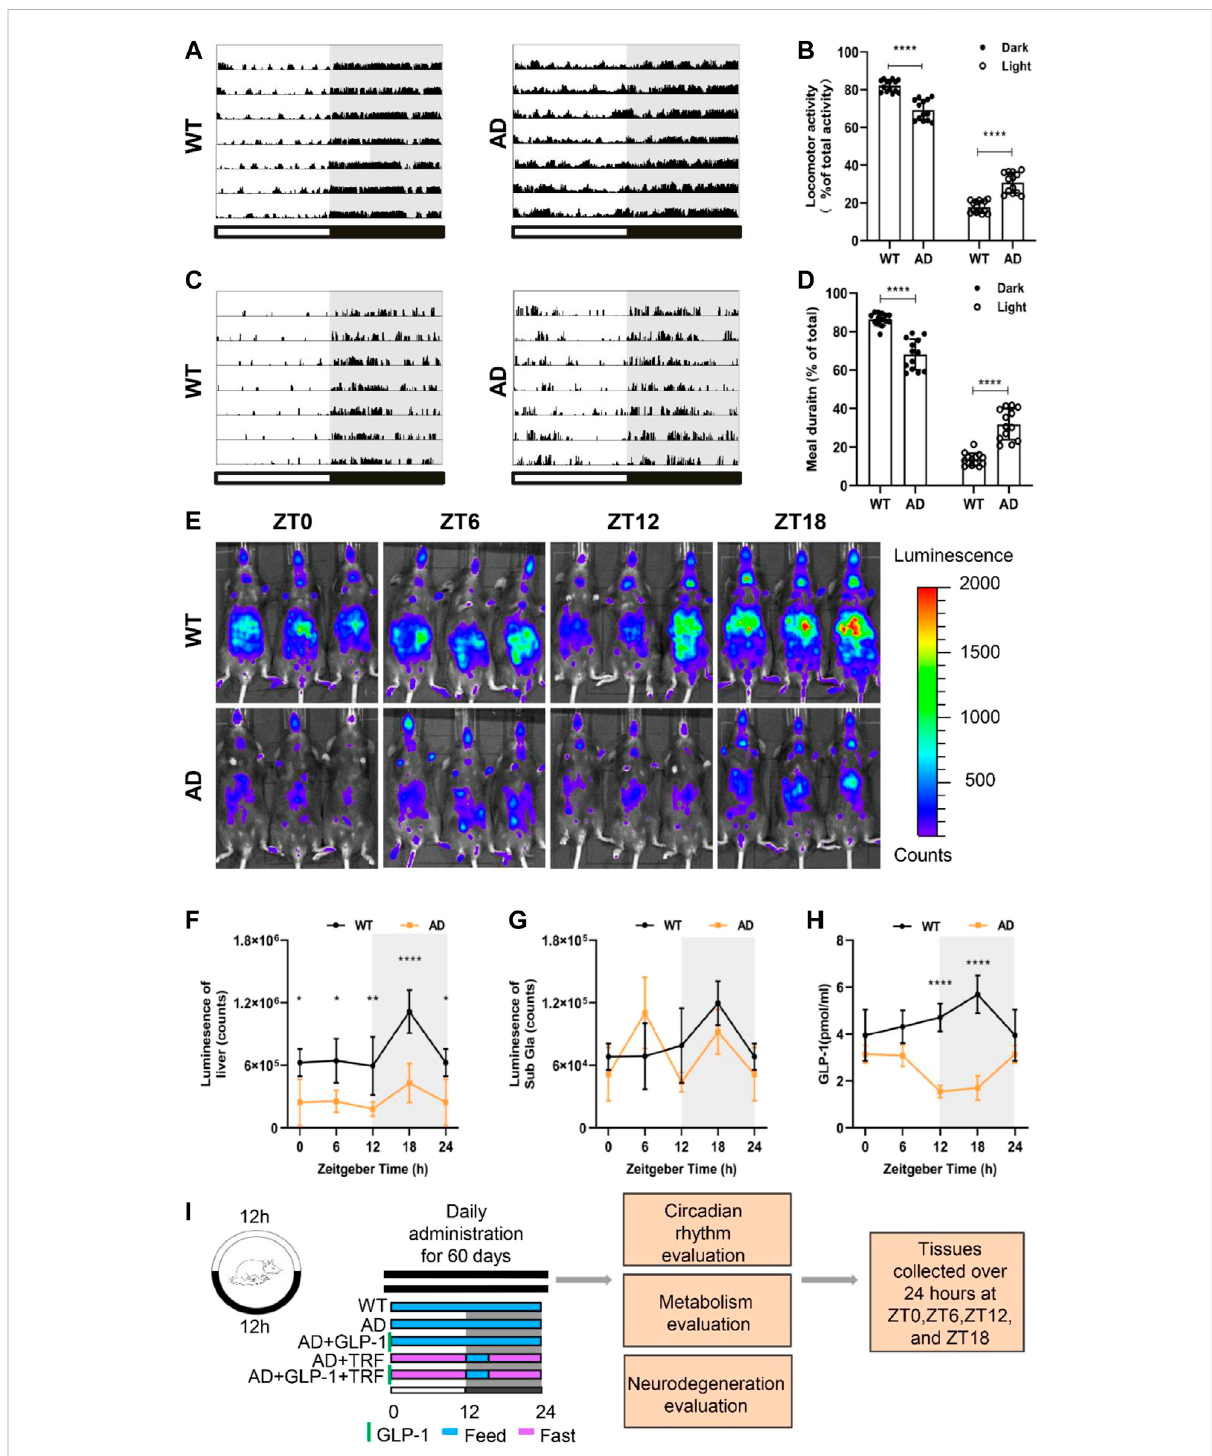
FIGURE 1 Alzheimer ’ s disease mice exhibit circadian rhythm disturbances. (A) Representative locomotor activity records of 5 × FAD mice (AD) and wild-type mice (WT), respectively. Locomotor activity was de fi ned as the moving distance per unit time (2 min). Each horizontal line represents 24 h. Periods of darkness are indicatedbygreybackgrounds.Theblackandwhitebarsonthebuttonindicate12 h-darkand12 h-lightperiods,respectively. (B) Percentageofthelocomotor activity in thedark and light/total activity (24 h). n = 7 per group, **** p < 0.0001, using two-way ANOVA followed by Sidak t test. (C) Representative meal durationrecordsoftwogroups. (D) Percentageofthemealdurationinthedarkandlight/totalmealduration(24 h). n =7pergroup,**** p < 0.0001,usingTwo- Way ANOVA followed by Sidak t test. (E) Representative photographs of PER2:LUC mice in vivo monitoring from each time point at 6 h intervals. (F,G) Raw photoncountdataofindividualbioluminescencerhythmsfromE. n =3pergroup, n =3pergroup,* p < 0.015,** p < 0.01usingTwo-WayANOVAtest. (H) GLP-1 secretion levels in both groups. (I) The protocol design of our